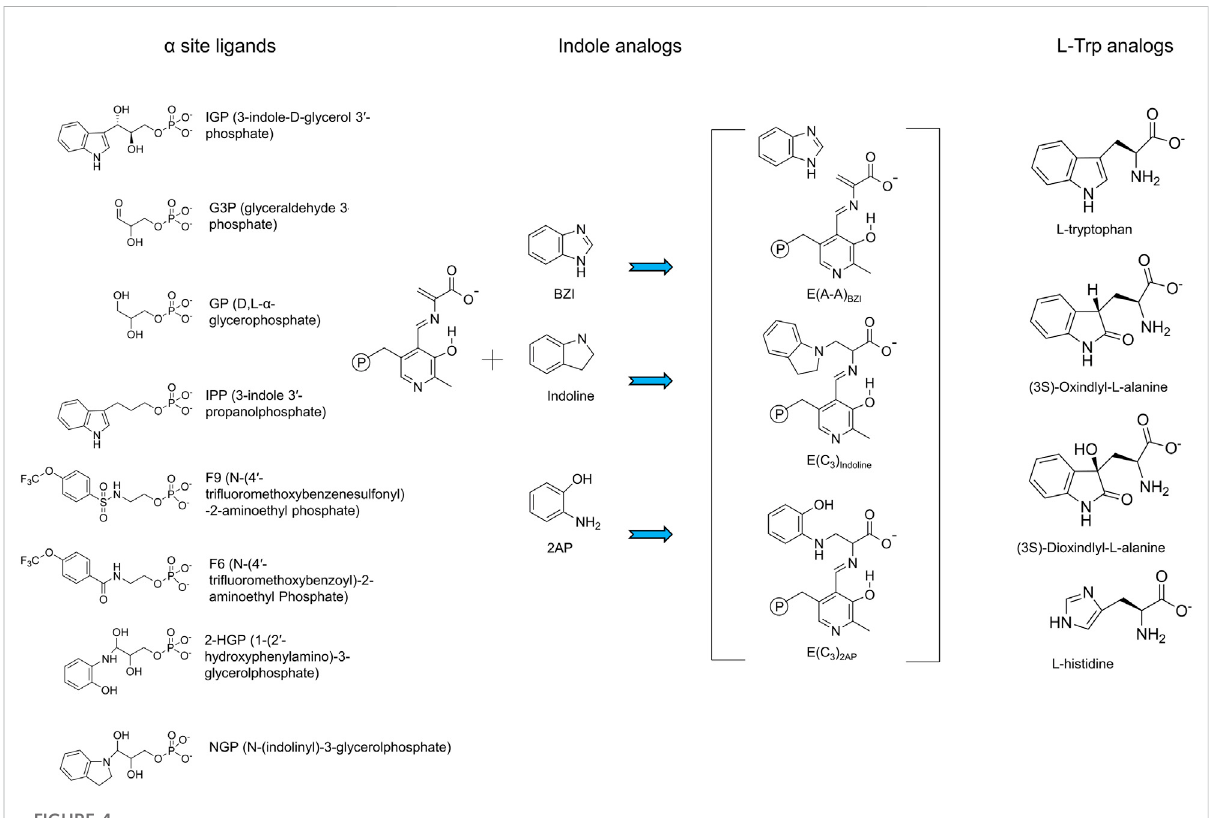
FIGURE 4 Summary of substrates and substrate